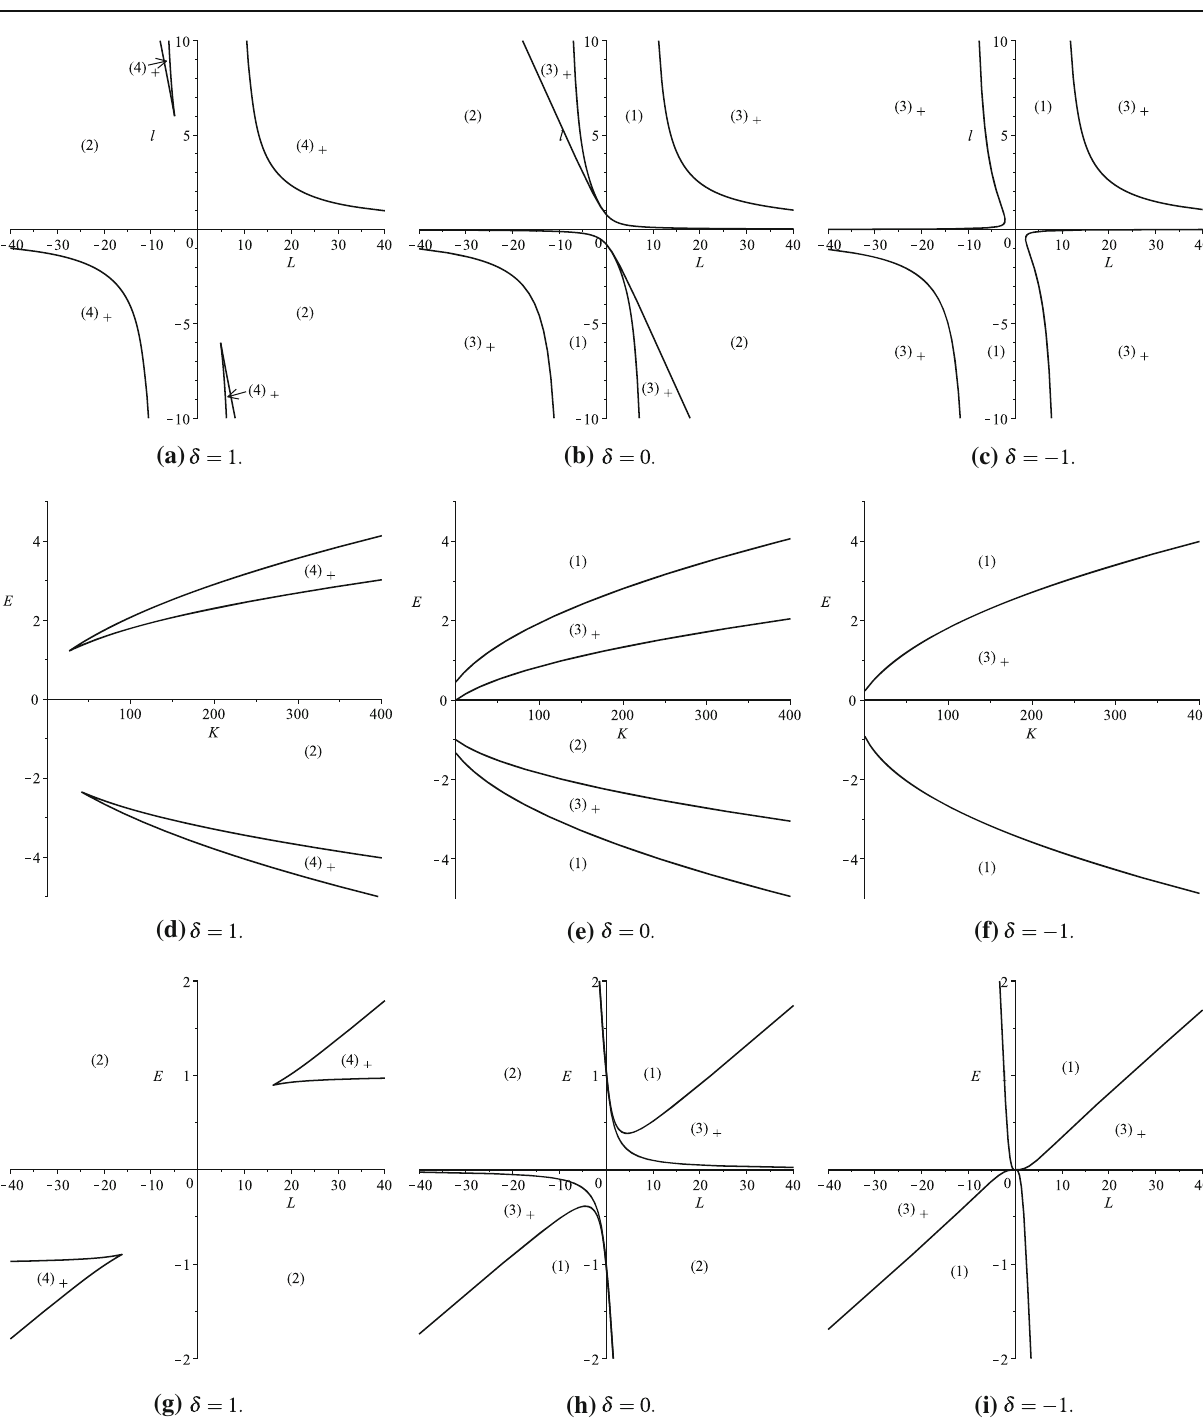
shown. Associated orbit types can be found in Table 1 and are described in Sect. 3.2.2. In cases ( d )–( i ) one double zero of P for E = 0 and all K or L can be found. Since no regions of different numbers of zeros are separated by these lines (see Fig. 3 for E = 0), they are